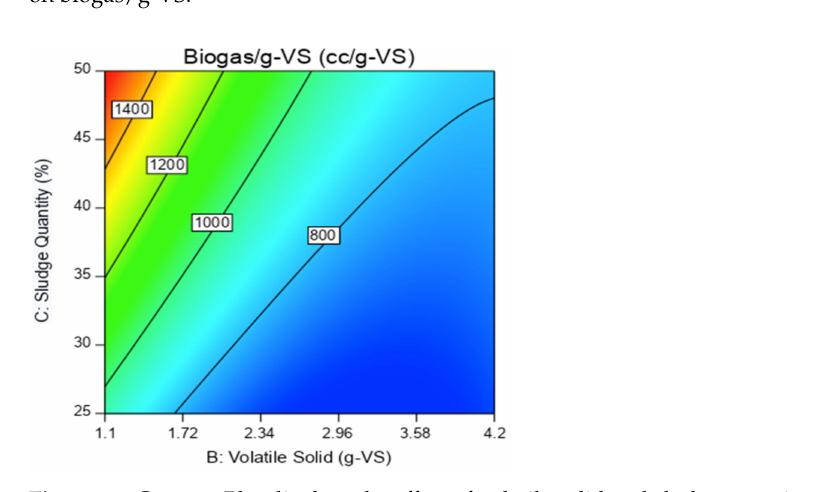
Figure 26. Contour Plot displays the effect of volatile solid and sludge quantity on the Biogas/g-VS at 37 ◦